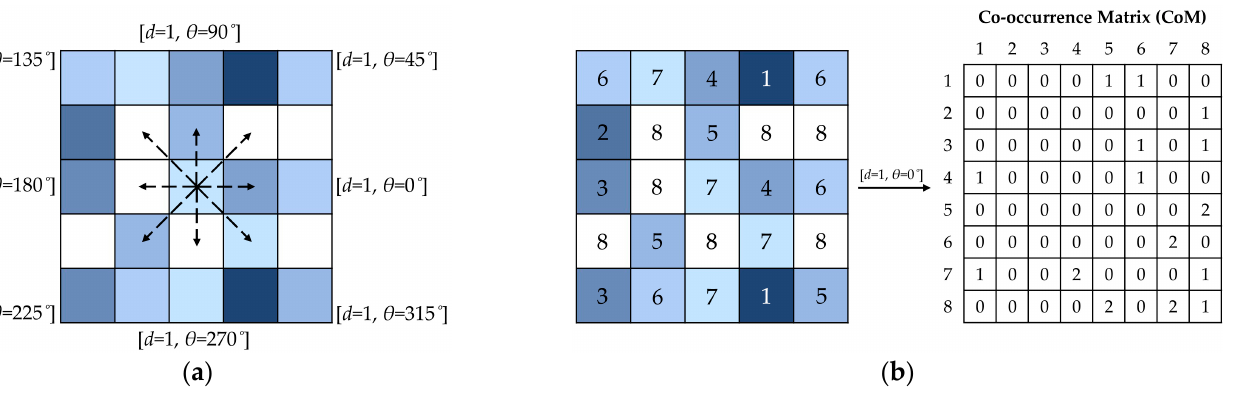
Figure 1. The displacement rules for generating CoMs with the distance d = 1 pixel, and rotation angles θ ∈ {0, 45, 90, 135, 180, 225, 270, 315}° ( a ). An example of a CoM for [ d = 1, θ = 0°] after reducing angles θ ∈ {0, 45, 90, 135, 180, 225, 270, 315} ◦ ( a ). An example of a CoM for [ d = 1, θ = 0 ◦ ] after reducing the image bit depth to n = 8 through quantization ( b ). the image bit depth to n = 8 through quantization ( b